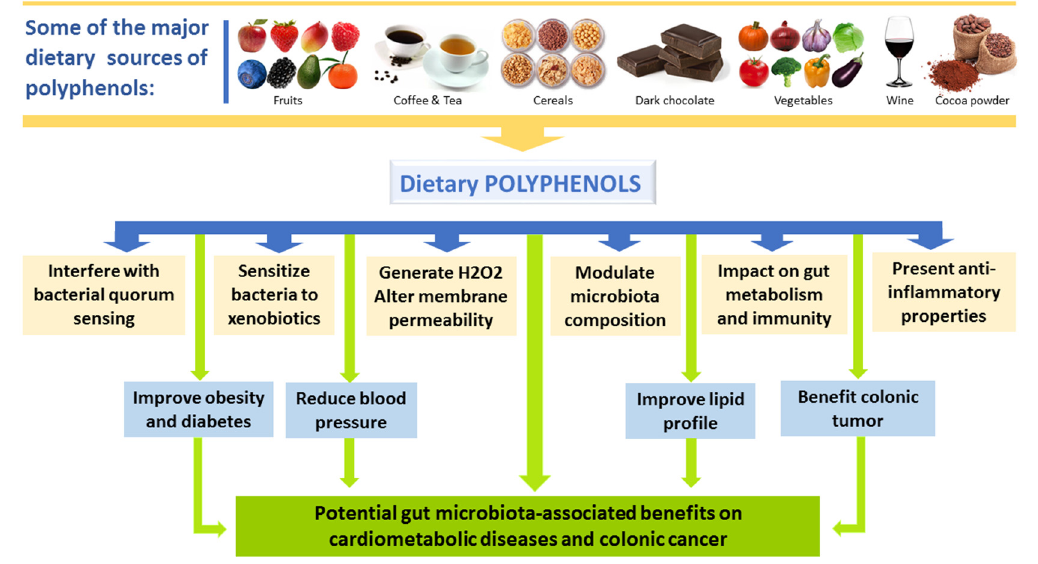
Figure 4. Major sources of dietary polyphenols and the potential gut microbiota-associated benefits on human health.